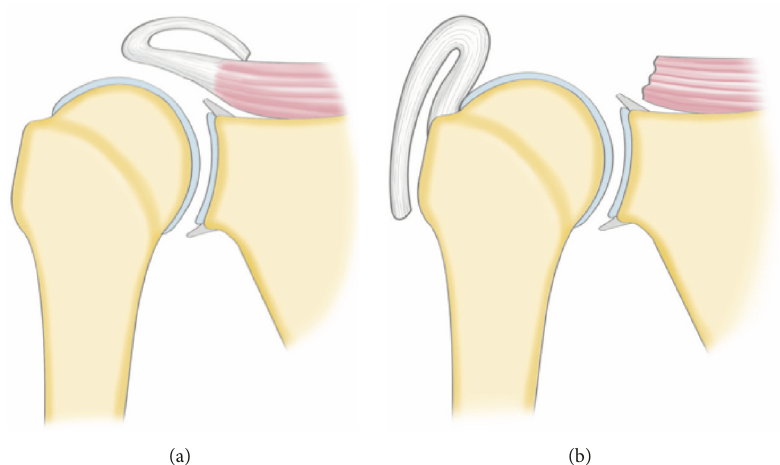
Figure 4: Illustration of a “Fosbury flop tear” (a) and of a “reverse Fosbury flop tear”